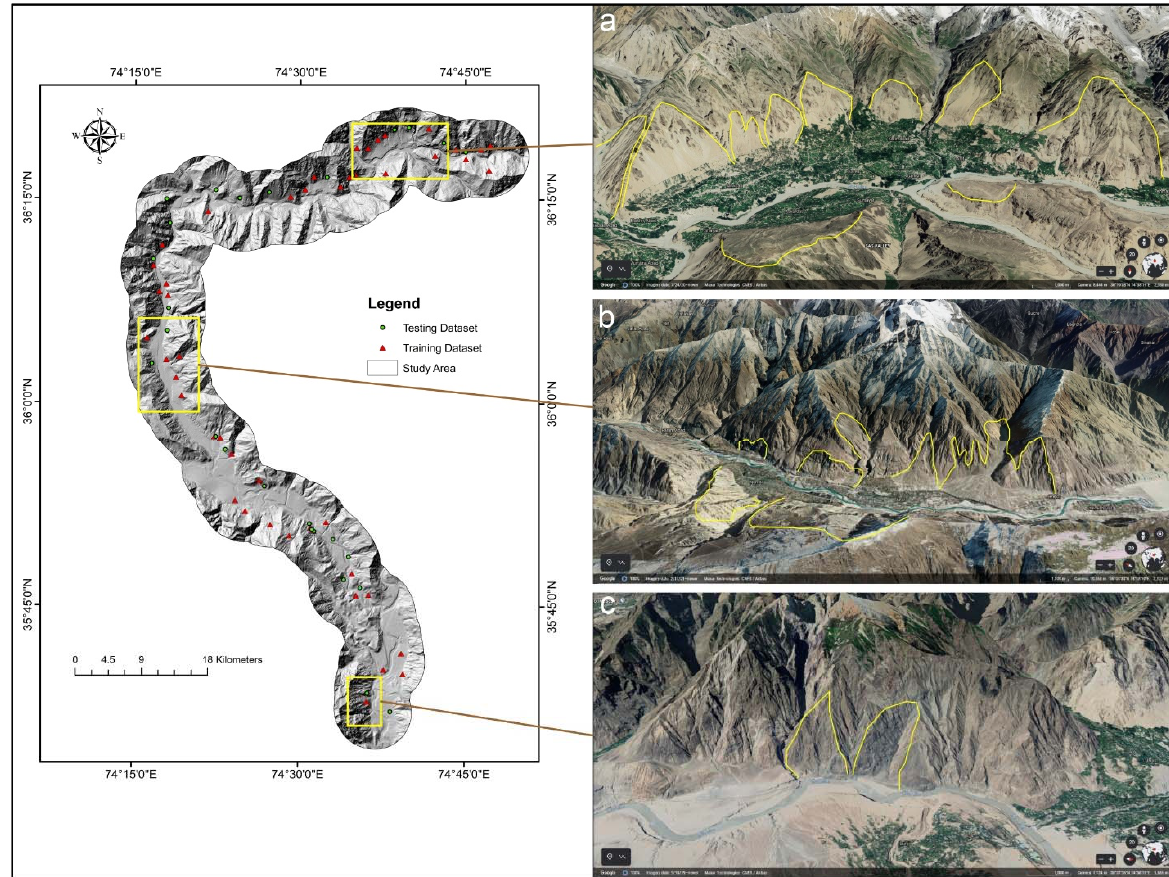
Figure 4. Landslide inventory in the research area. ( a ) A Google Earth image showing the debris flow in the Karimabad area. ( b ) Scree slopes and rockfall landslides near the Gilgit area. ( c ) Rockfall landslide in the Jaglot area.